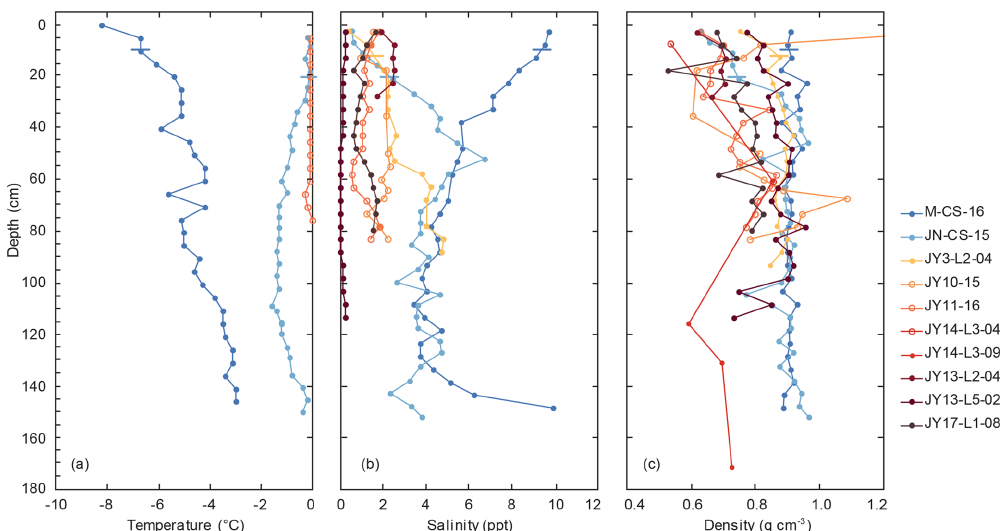
Figure 7. Ice core profiles of (a) temperature, (b) salinity, and (c) density showing changes in ice properties over the course of summer melt. Open circles indicate cores of ponded ice. The position of freeboard is indicated by a horizontal bar in cores in which freeboard was measured; note that for ponded ice, the ice was below freeboard. Ice cores were analyzed as follows: May (M-CS-16, dark blue), June (JN- CS-15, light blue), July 2015 (3 July core, JY3-L2-04, yellow; 10 July rotten core from sediment-rich ponded ice, JY10-15, orange; 11 July rotten core from ponded ice, JY11-16, dark orange; 14 July rotten core from ponded ice, JY14-L3-04, red, open circle; 14 July rotten core from non-ponded ice, JY14-L3-09, red, closed circle), and July 2017 (13 July Floe 2 JY13-L2-04, magenta; 13 July Floe 5 JY13-L5-02, purple; 17 July Floe JY17-L1-08,